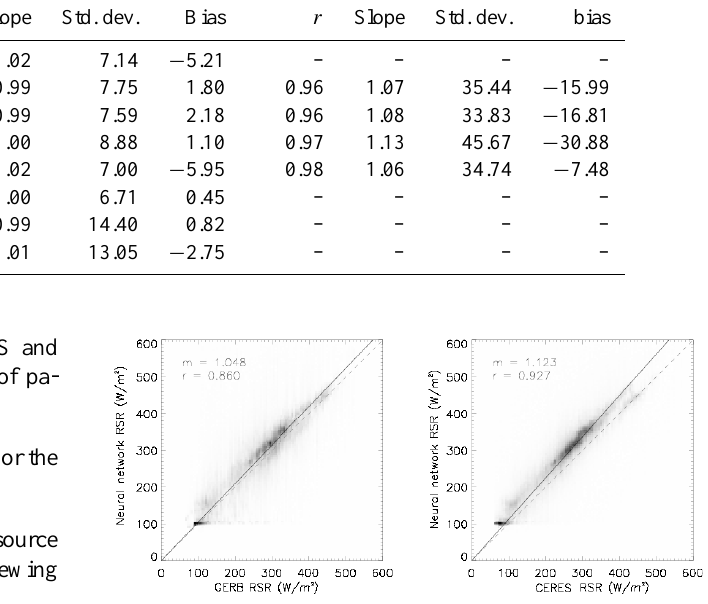
Fig. 10. Comparison between GERB and CERES observations of the RSR and the RRUMS retrieval shown in Fig. 9. The solid line corresponds to the linear fit y = mx and the dashed line shows the 1 : 1 ideal behaviour, for reference. Date: 1 January 2007, 10:00UTC